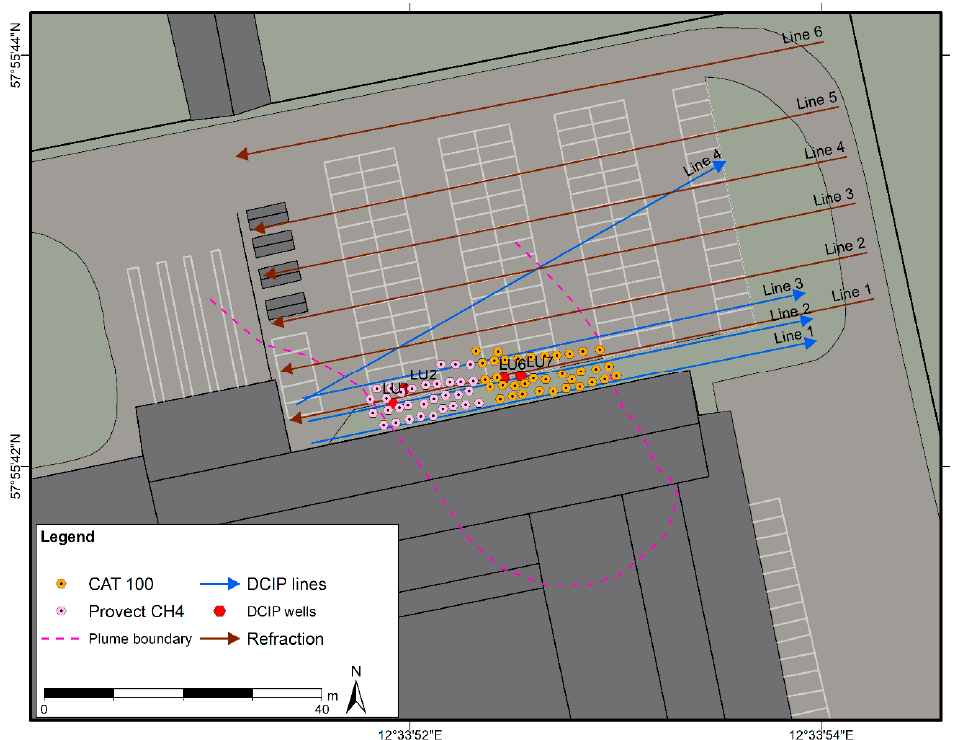
Figure 3. Overview of the geophysical survey and initiated pilot in-situ bioremediation. Seismic refraction tomography (brown lines) electrical resistivity tomography (blue lines), injection area A where the Provectus ERD-CH4 TM was injected (purple points) and injection area B where the CAT100 ™ was injected (orange points). The four boreholes used for cross-hole tomography are marked as red dots (LU1, LU2, LU6 and LU7). The boundaries of the plume are marked with purple dashed line.